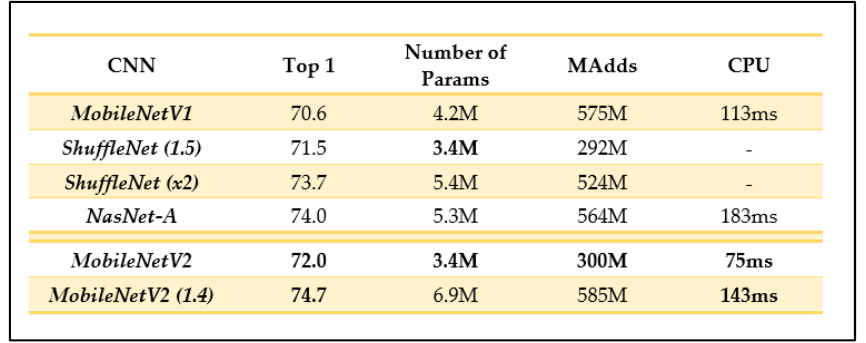
Figure 8. Comparison of MobileNetV2 results and other recent CNN architectures (as outlined in